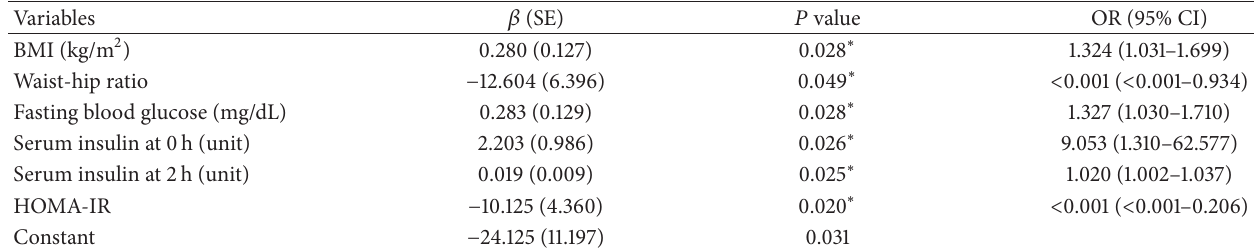
Table 8: Model for predicting ≥ 2 sensory nerves involved (Model 4).